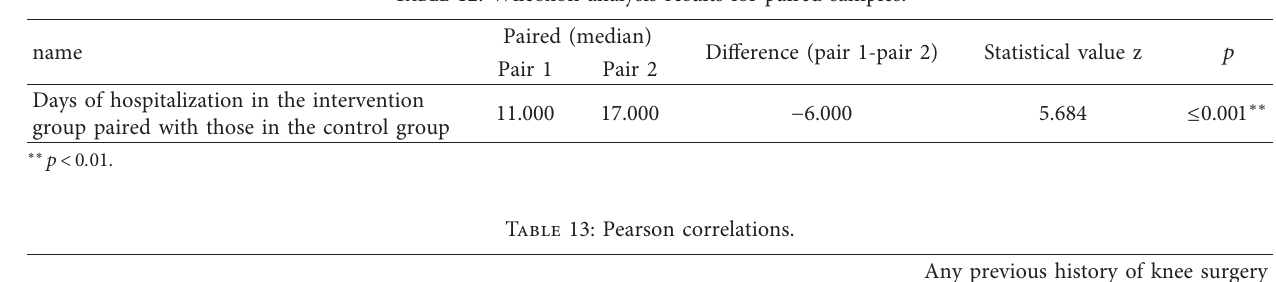
Table 12: Wilcoxon analysis results for paired samples.